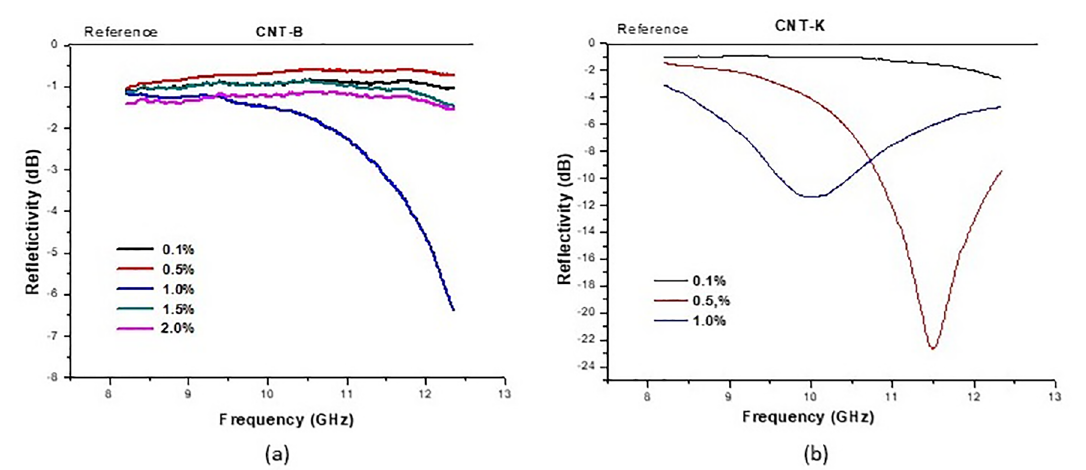
Figure 7. Reflectivity curves in function of frequency of nanostructured composite containing (a) CNT-B and (b) CNT-K in epoxy resin, with 9